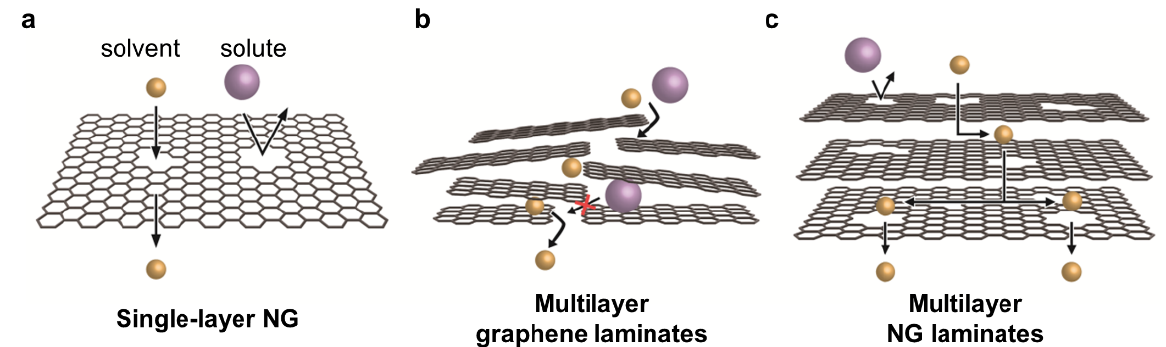
Figure 1. Three categories of graphene-based membrane used for OSN: ( a ) single-layer NG, ( b ) multilayer graphene laminates, and ( c ) multilayer NG laminates.